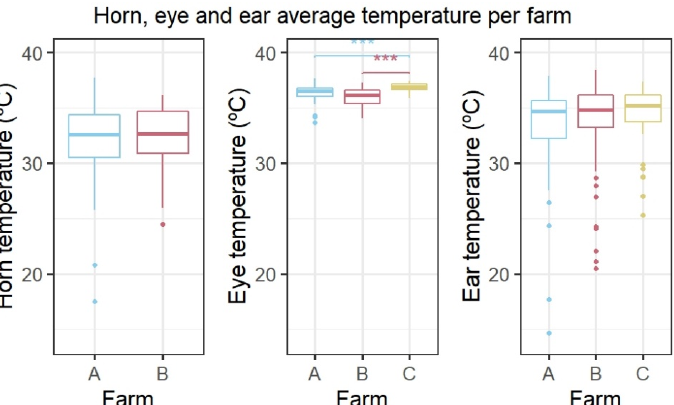
Figure 2. Horn, eye, and ear temperature per farm. ( Left ): horn temperature per farm. ( Middle ): eye temperature per farm. ( Right ): ear temperature per farm. Farms A and B had horned cows and farm C dehorned cows, so no difference in horn temperature could be calculated. Data were averaged per round. *** p -value < 0.001. Horn temperature (averaged per observation) was positively correlated to HLI and air temperature, whereas humidity and wind speed showed a negative correlation (Figure 3). All repeated measures correlations were significant (HLI: r rm (560) = 0.60, 95% CI [0.54, 0.65], p < 0.001, environmental temperature: r rm (560) = 0.70, 95% CI [0.65, 0.74], p < 0.001), humidity: r rm (560) = − 0.30, 95% CI [ − 0.38, − 0.23], p < 0.001), wind speed: r rm (560) = − 0.20, 95% CI [ − 0.28, − 0.12], p < 0.001).